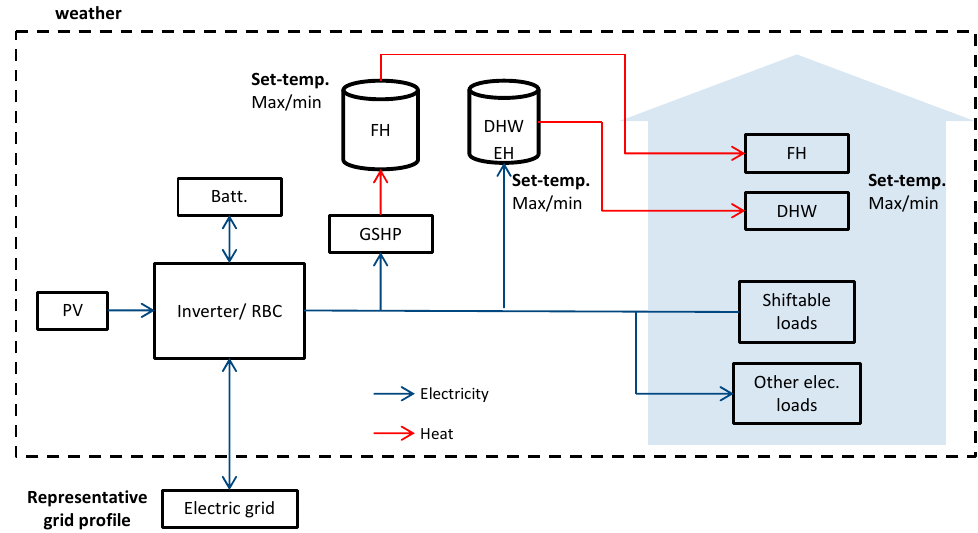
Figure 1. The energy system of the studied building.